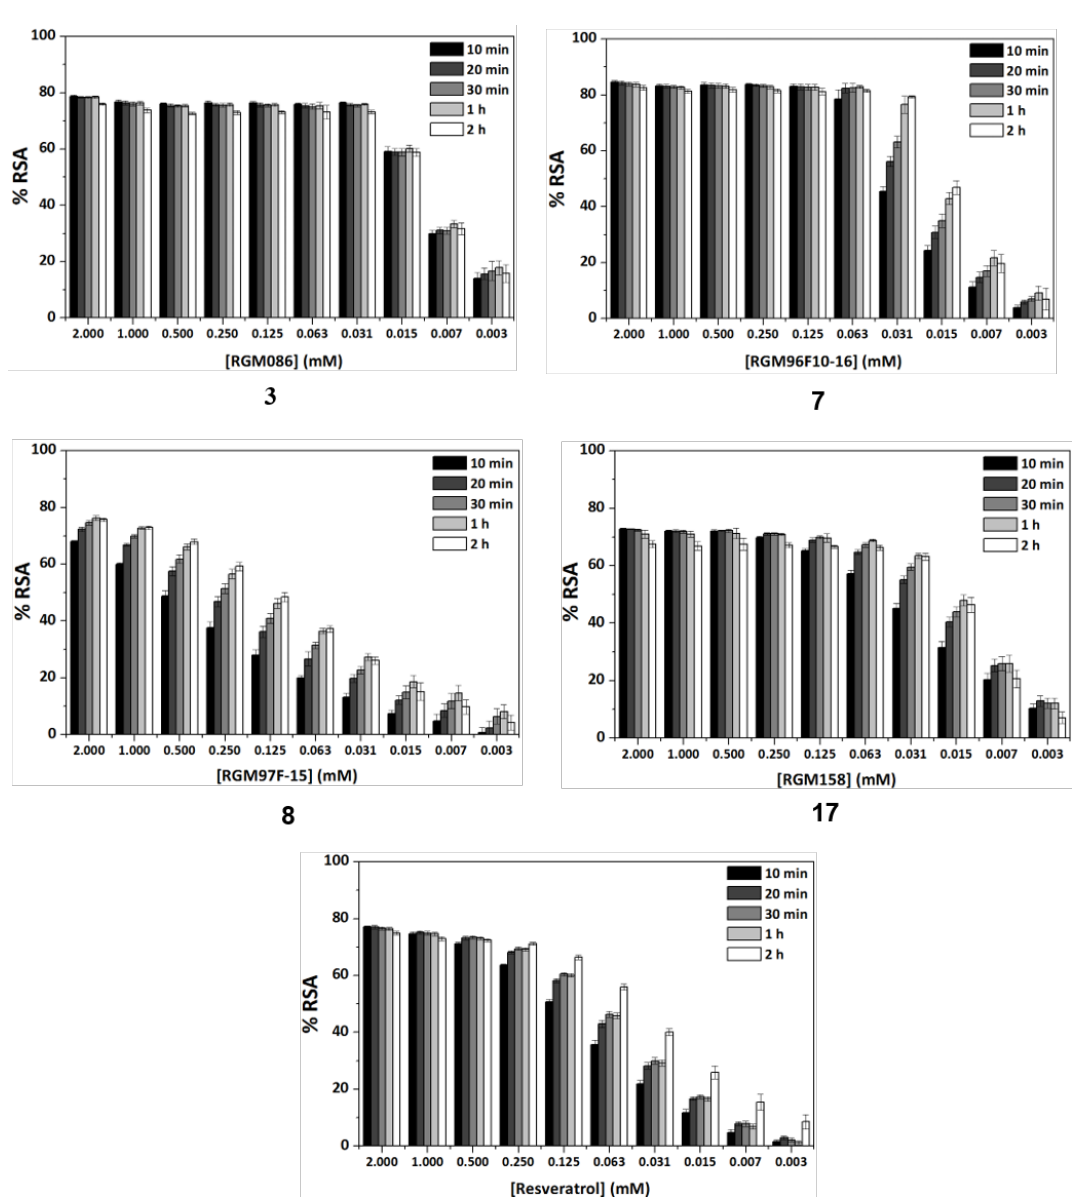
Figure 1. Study of the radical scavenging activity (RSA) capacity showed by compounds 3 , 7 , 8 and 17 and control (resveratrol) low in the DPPH assay. Variations with sample concentration and